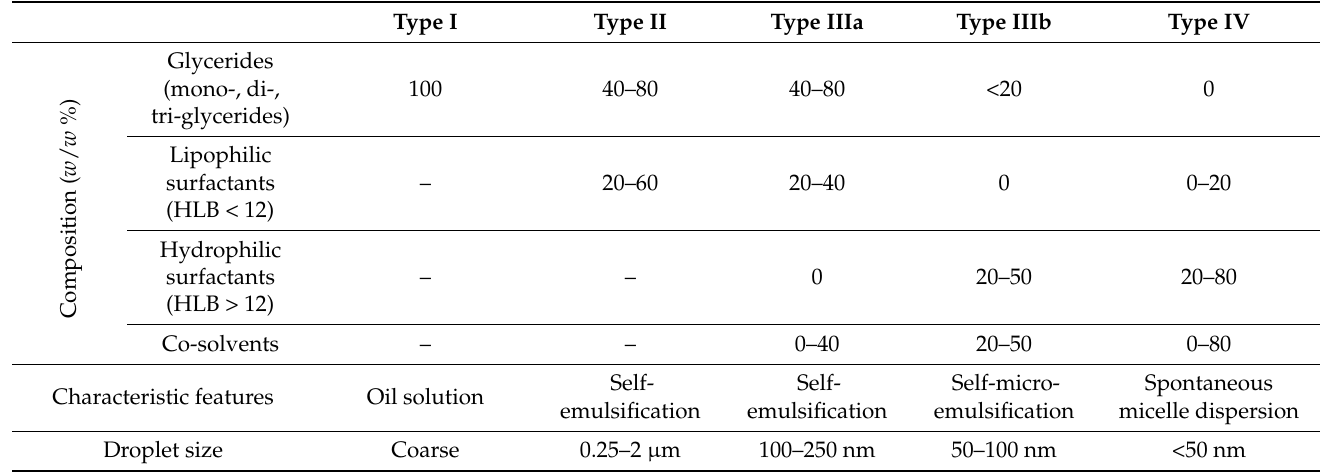
Table 1. The features of four essential lipid formulation types in the lipid formulation classification system